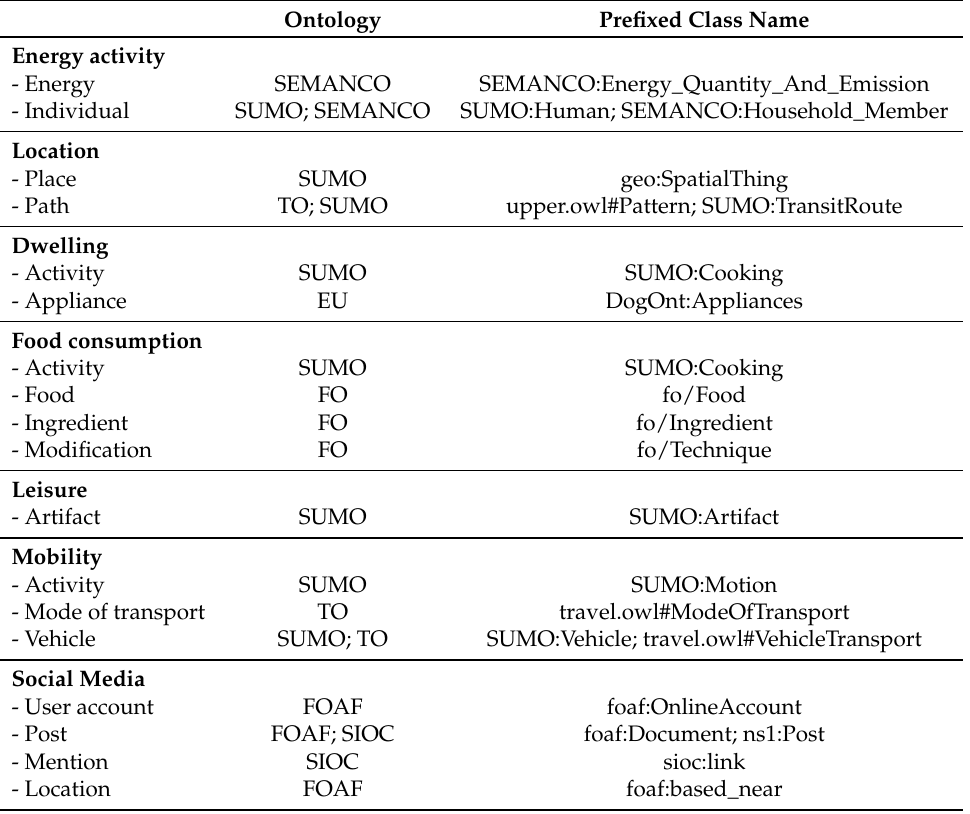
Table 2. Overview of the entities in the SSMO ontology reused from existing ontologies. Ontology